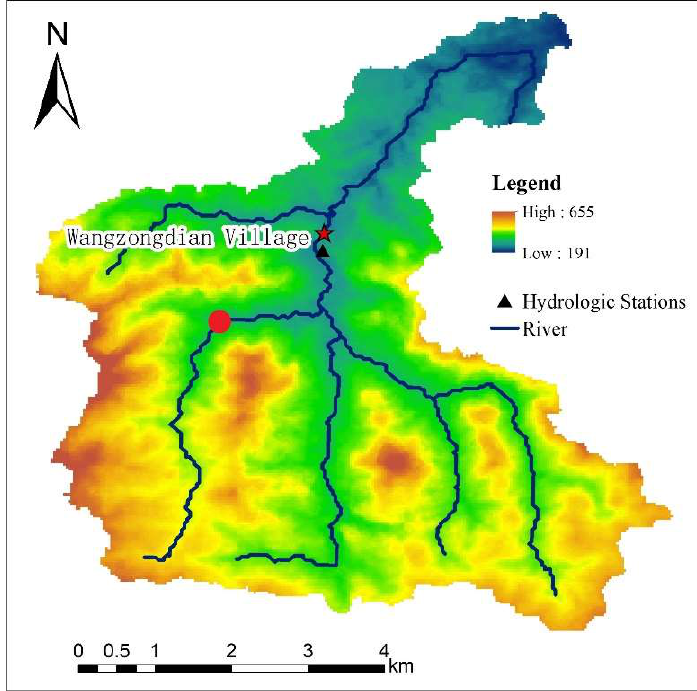
Figure 4. Digital Elevation data of Wangzongdian watershed.